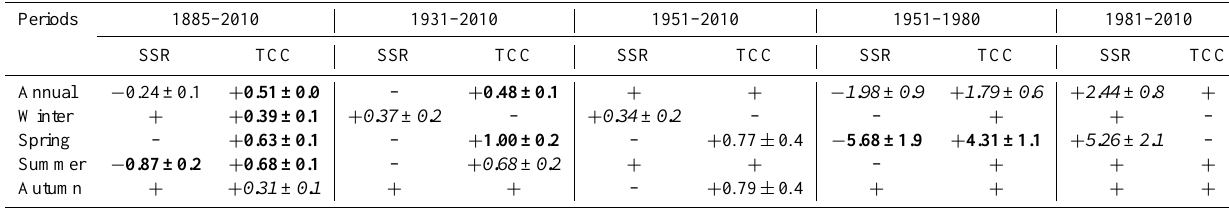
Table 4. Annual and seasonal estimated SSR and TCC trends ∗ (together with their standard deviation) in Switzerland over different subpe- riods.